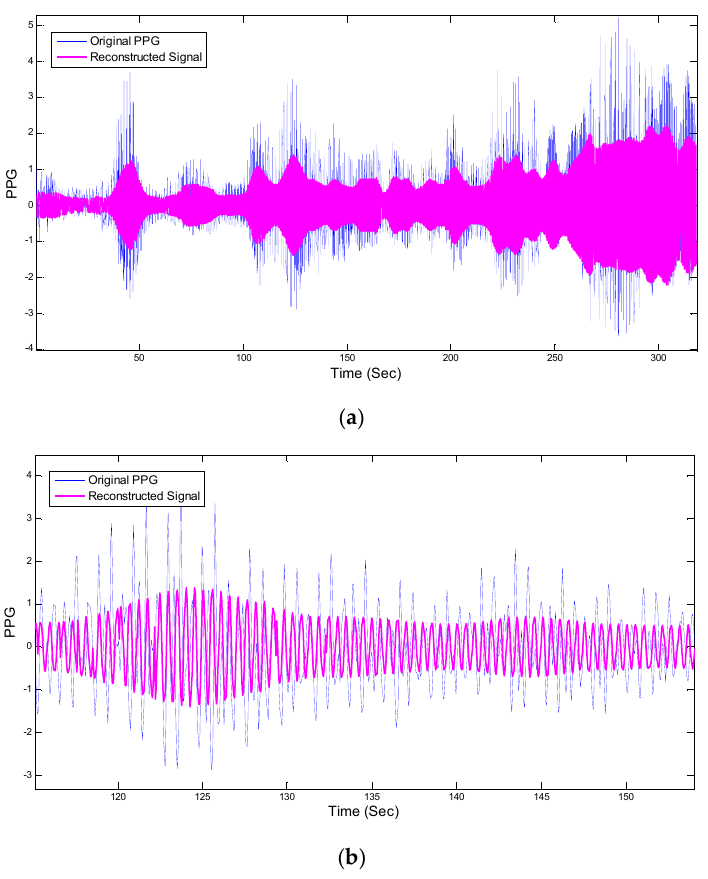
Figure 6. PPG signal reconstruction. ( a ) Comparison between reconstructed PPG and original recording #8 from IEEE competition training dataset; ( b ) Zoomed-in version of ( a ).